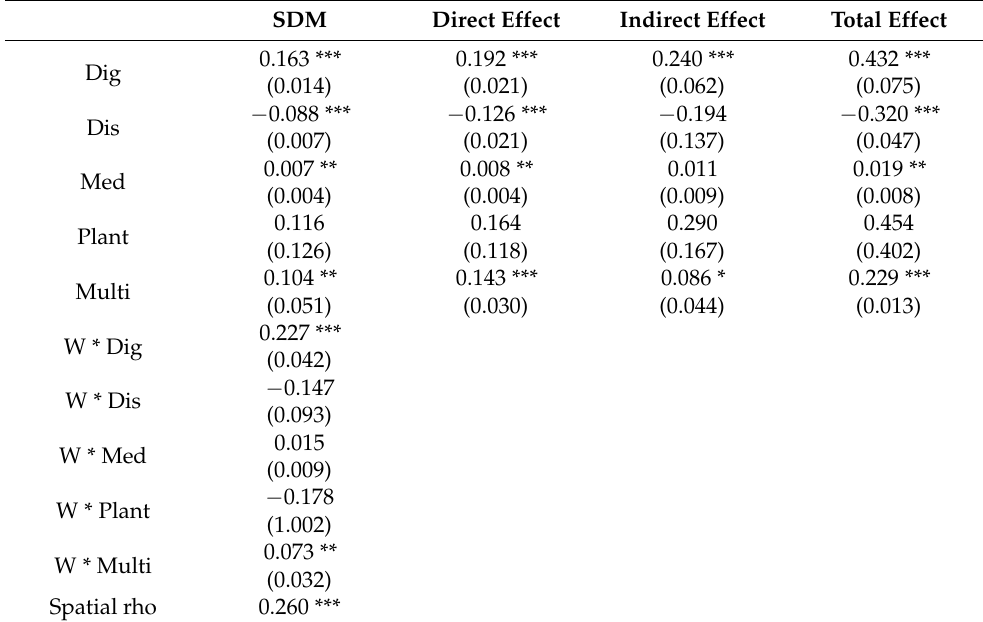
Table 9. Regression results of spatial Dubin